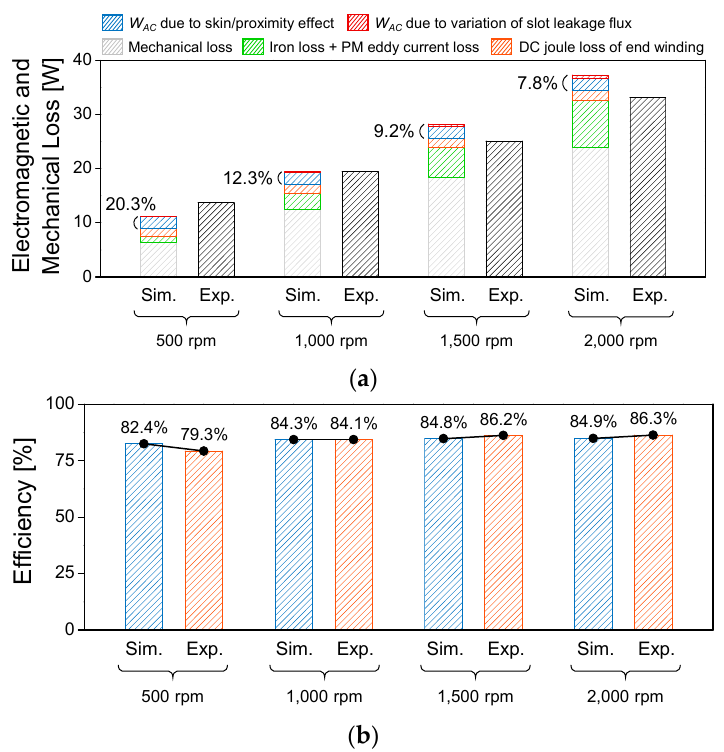
Figure 11. Comparison of experimental results with simulation results for ( a ) total loss and ( b ) efficiency.